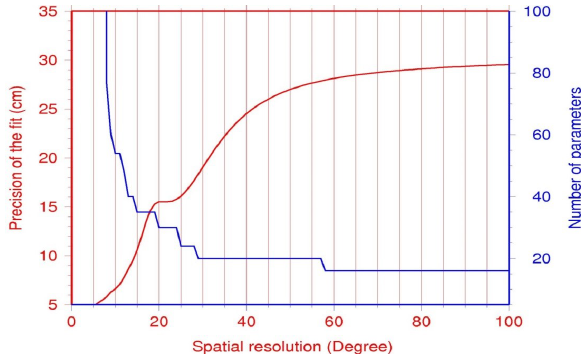
Figure A.1: The model precision and the number of the correspond- ing coefficients versus the spatial resolution of the B-spline model. The red curve is the model precision referring to the left axis. The blue curve is the number of the parameters referring to the right.